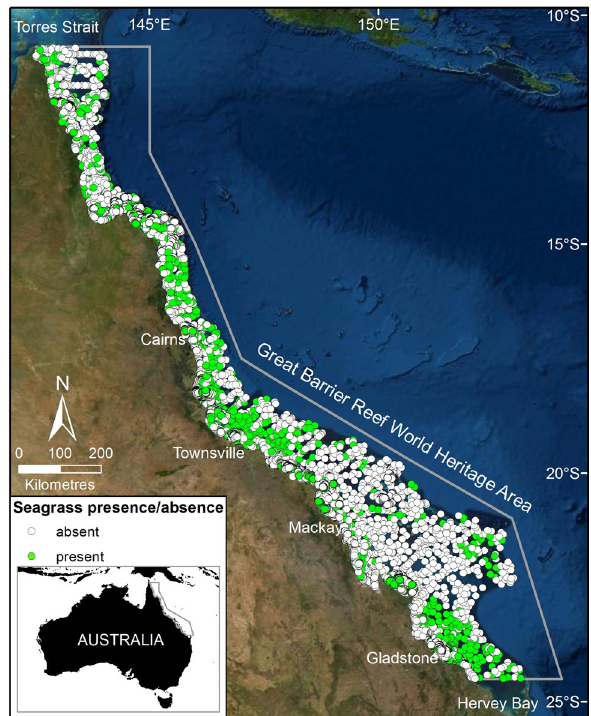
Figure 8. Seagrass presence and absence at sampling sites across the Great Barrier Reef World Heritage Area (grey boundary). Map created using ArcGIS software version 10.8 by Esri (www. esri. com). Satellite image copyright